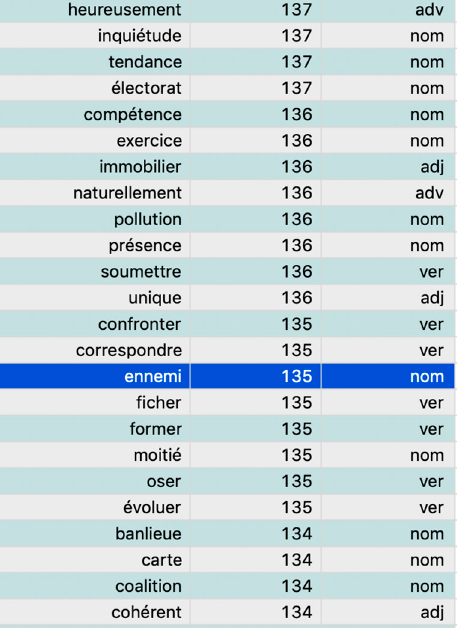
Figure A1. Lemmas of the Complete Corpus.